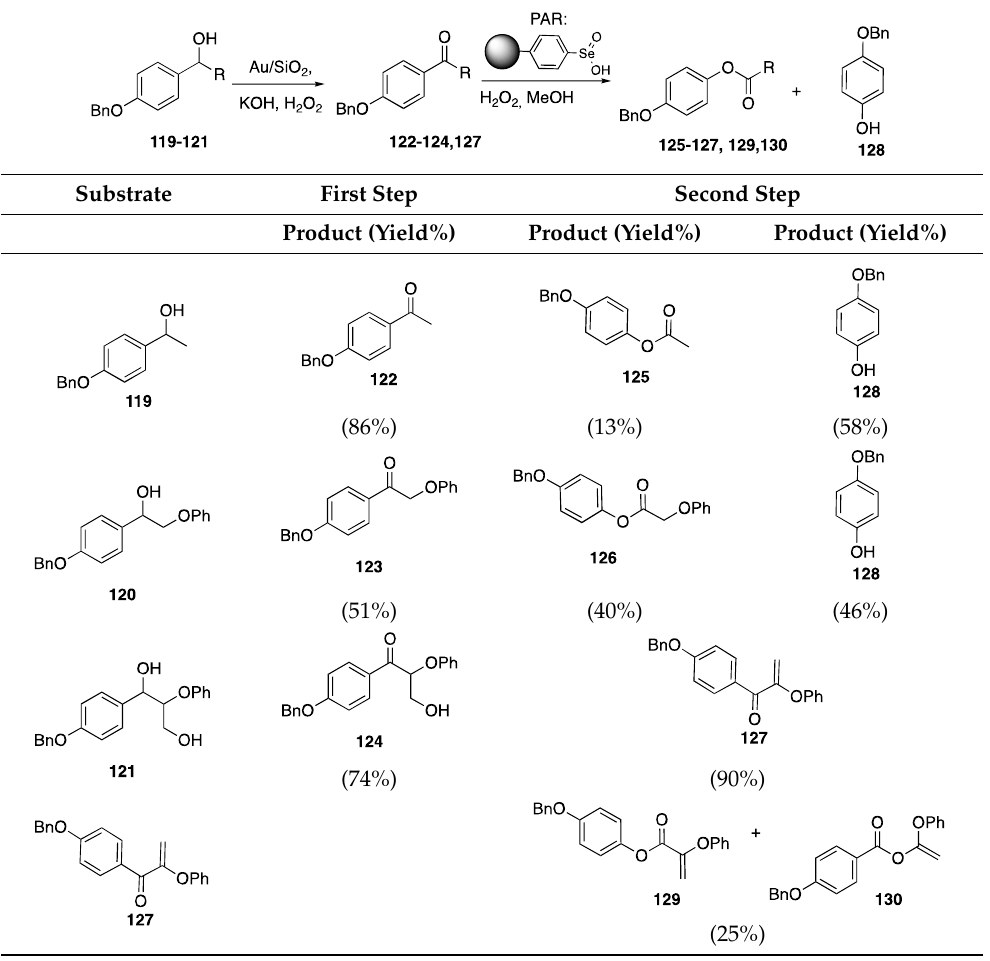
Table 6. Lignin model compounds oxidation.